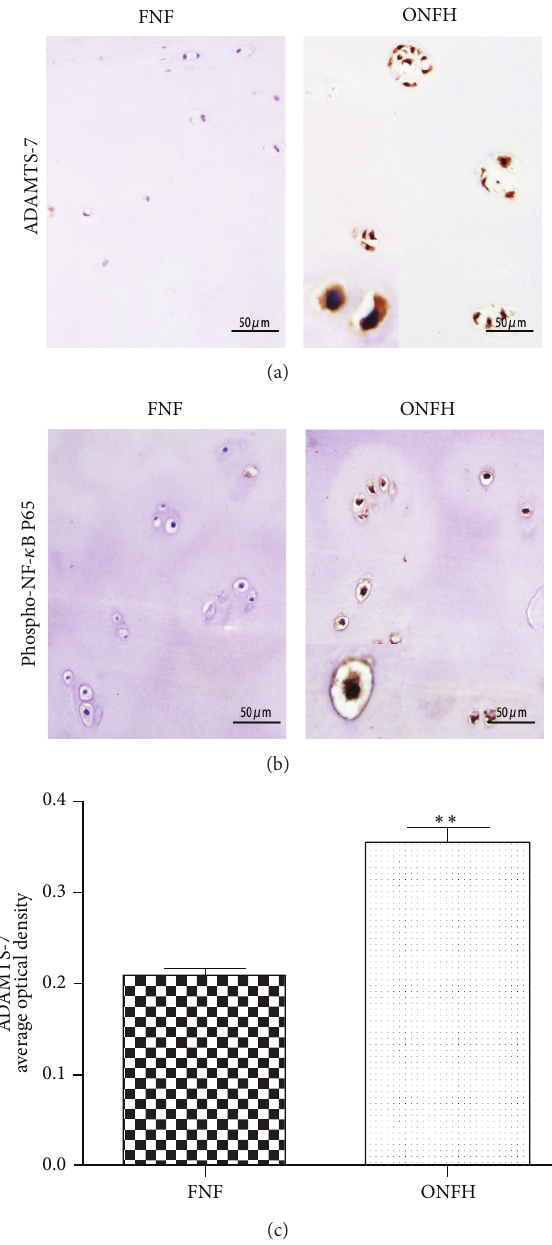
Figure 5: ADAMTS-7 and Phospho-NF- 𝜅 B P65 are upregulated in ONFH patients compared to FNF patients. (a) ADAMTS-7 expression of articular cartilage of FNF patients and ONFH patients, assayed by immunohistochemistry. (b) Phospho-NF- 𝜅 B expression in FNF group and ONFH group, examined by immunohistochemistry. The ONFH group exhibits high expression of Phospho-NF- 𝜅 B, and the FNF articular cartilage shows rare Phospho-NF- 𝜅 B expression. (c) Quantitative analysis of ADAMTS-7 area of FNF and ONFH group by average optical density ( ∗ 𝑃 < 0.05 , ∗∗ 𝑃 < 0.01